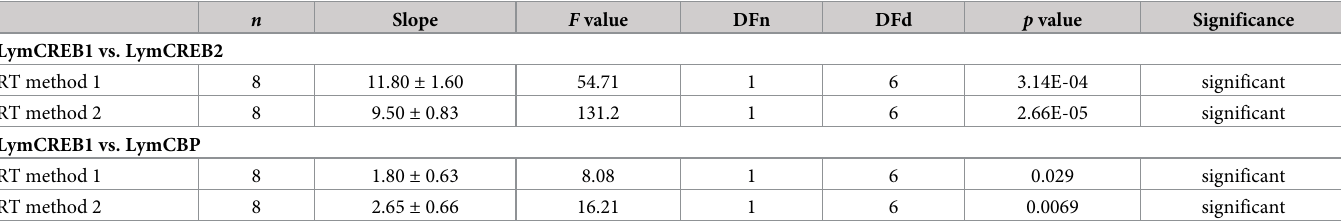
Table 3. Results of linear regression F -tests analyzing the correlation between the mRNA levels of LymCREB1 vs. LymCREB2 and LymCREB1 vs. LymCBP calcu- lated from absolute quantification data. Regression lines are shown in Fig 7. DFn: degrees of freedom in the numerator, DFd: degrees of freedom in the